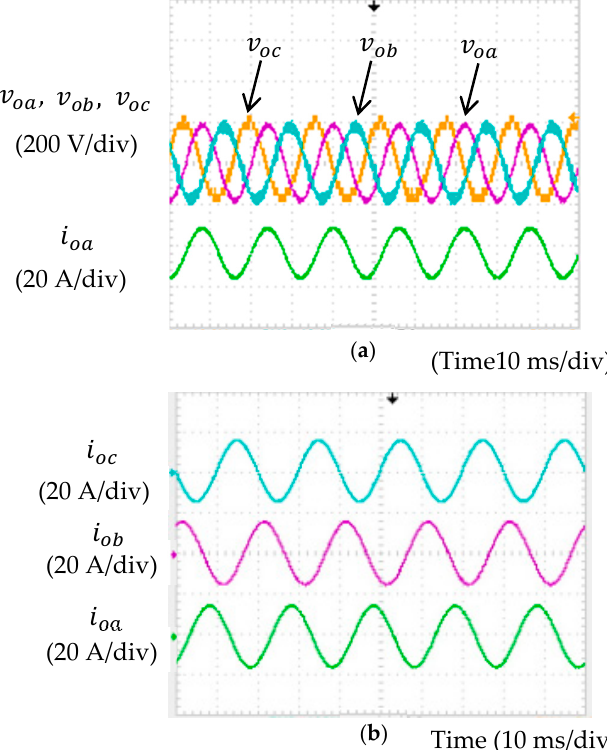
Figure 16. The measurements waveforms of three-phase input voltages along with input currents: ( a ) input three-phase voltage with input current of phase (A), ( b ) input current phase (A), input current (B), and current phase (C).